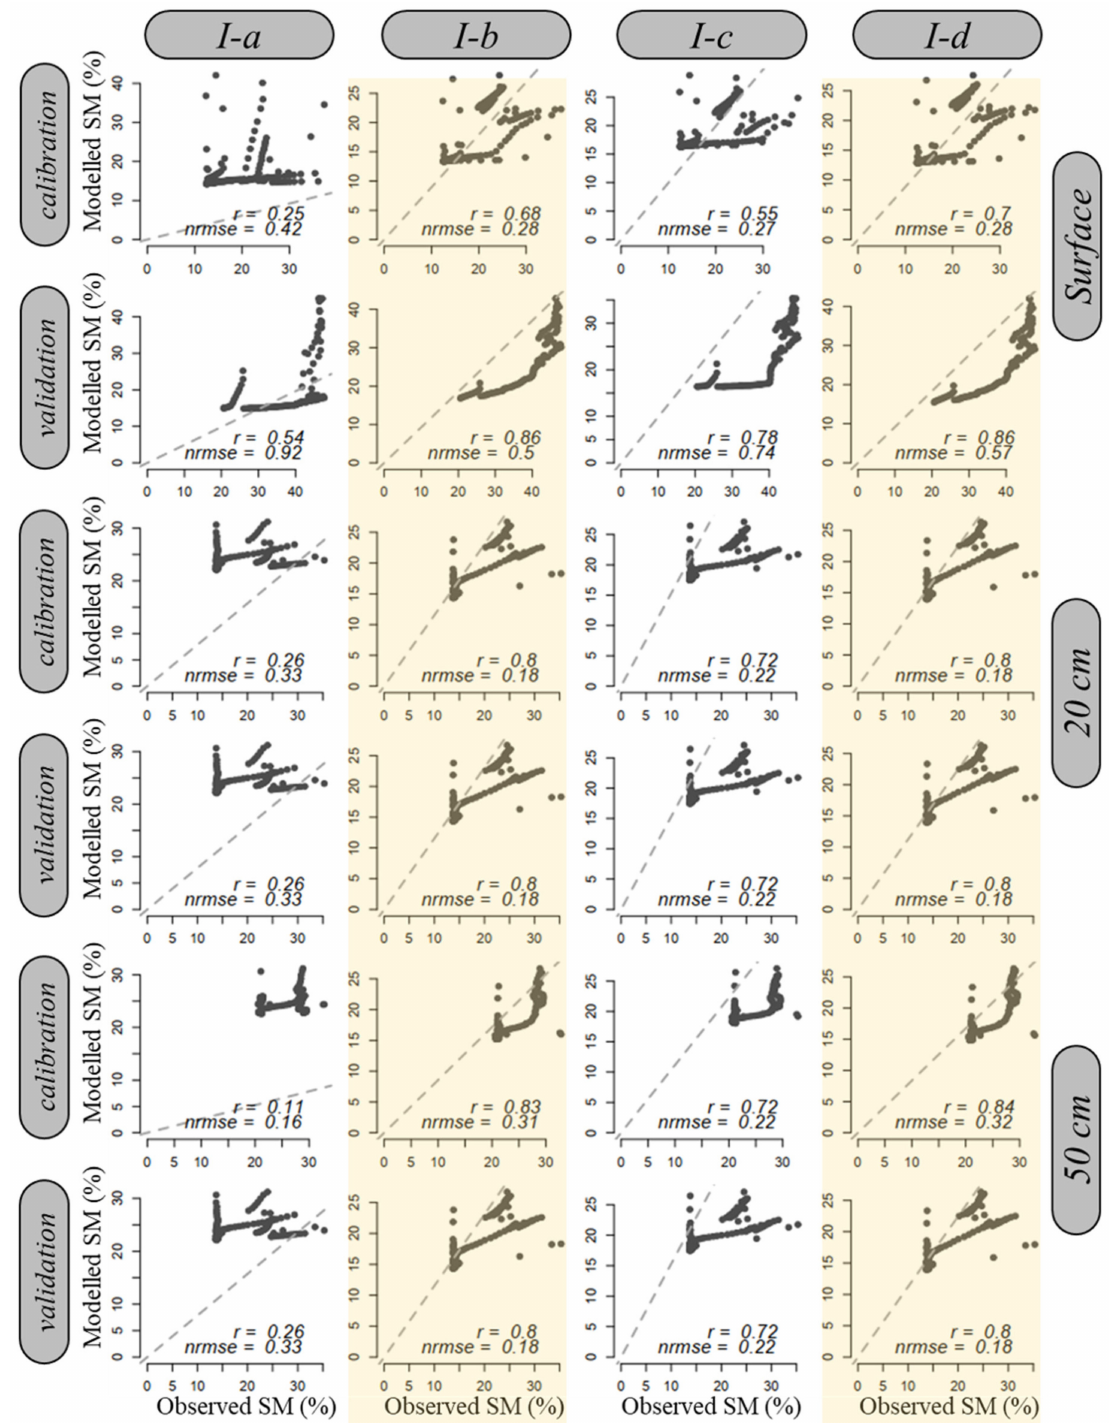
Figure 11. Comparison of the output soil moisture from I-a , I-b , I-c , and I-d treatments corresponding surface, 20 cm, and 50 cm deep layers with HDS soil moisture. Plots corresponding to each layer’s (surface, 20 cm, and 50 cm) calibration and validation are